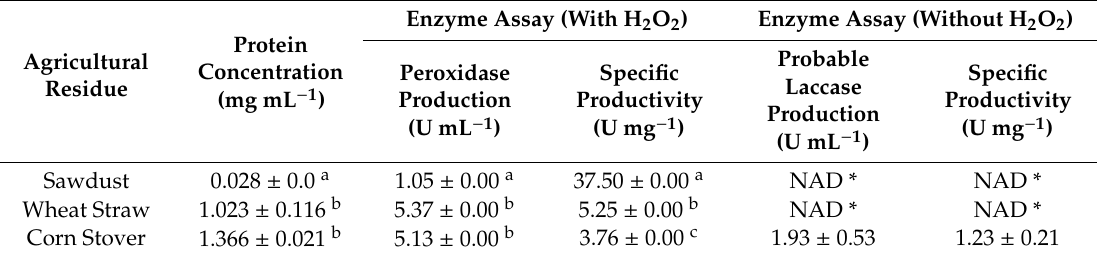
Table 1. Utilization of some agricultural residues for exoperoxidase production by Ensifer adhaerens